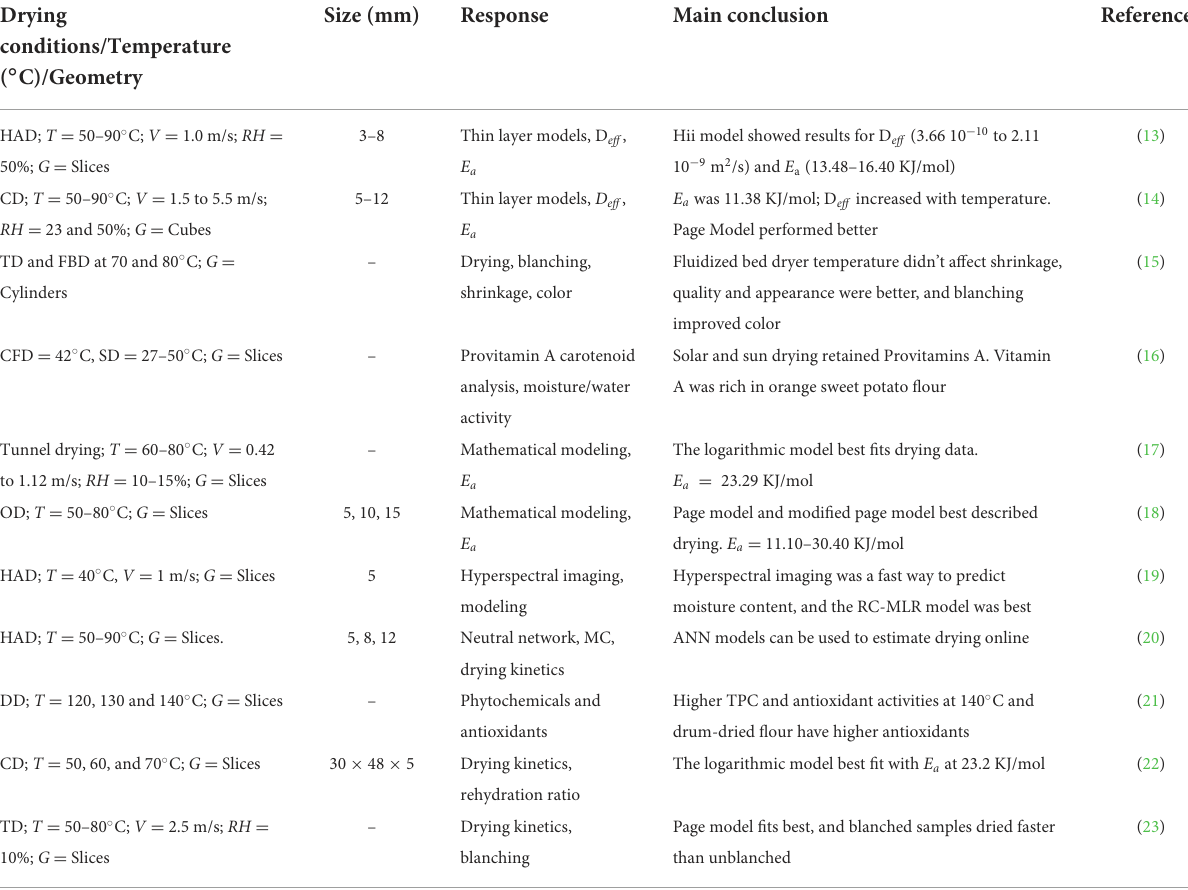
TABLE 1 Hot air-drying (HAD) studies were conducted to dry sweet potatoes.